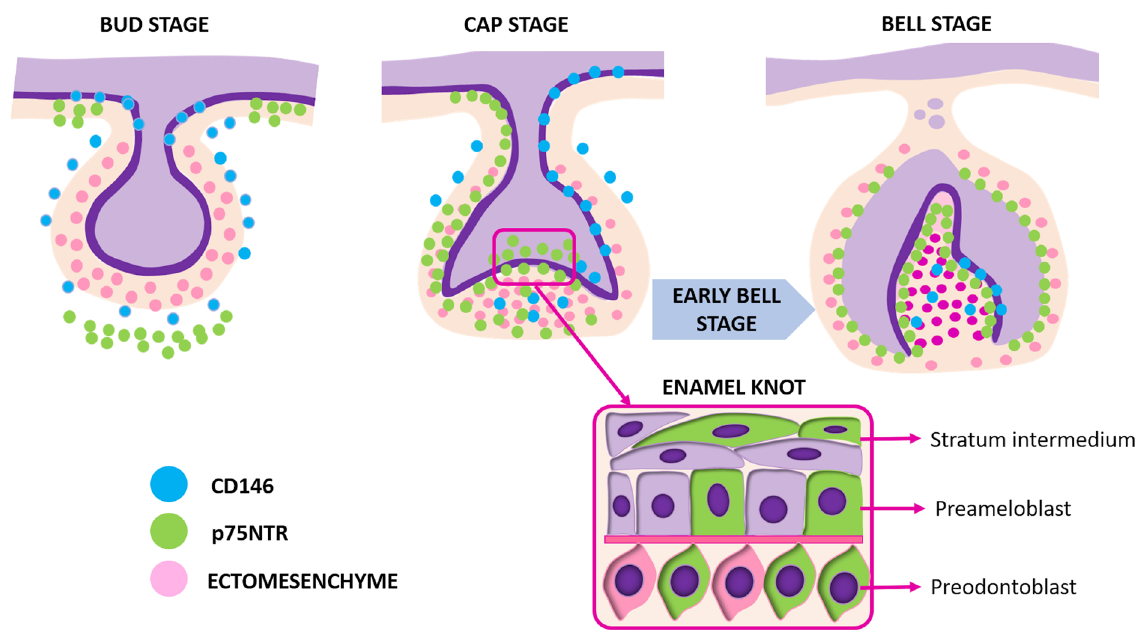
Figure 2- Schematic representation of the immunopositivity for CD146 and p75NTR in the stages of odontogenesis. In the box, we represent an enamel knot during the early bell stage. These signaling centers are responsible for the epithelial-mesenchymal interaction necessary for the regulation of tooth morphogenesis. In this region, both epithelial and ectomesenchymal cells were positive for